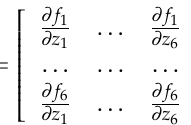
Table 3. Overall performance requirements in flight profile.